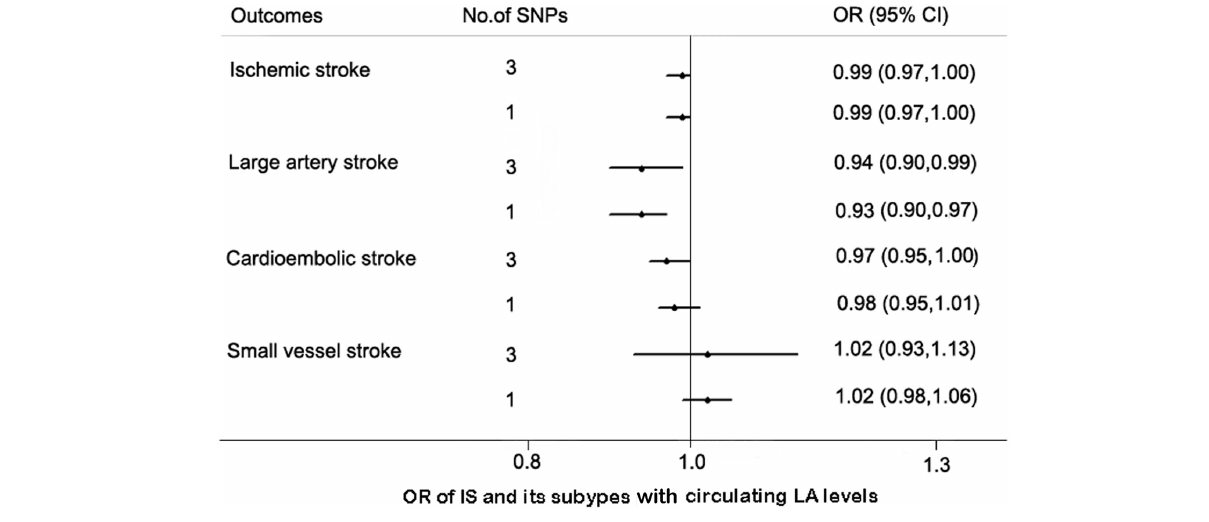
Frontiers in Genetics |